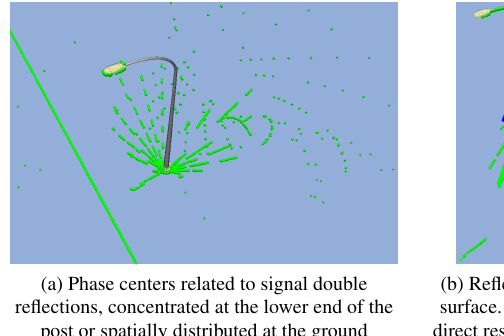
Figure 7. Simulated height profiles in range direction based on the selection of the most prominent pixel in the SAR image. The azimuth interval refers to the pixel size (= TerraSAR-X pixel spacing for spotlight mode).